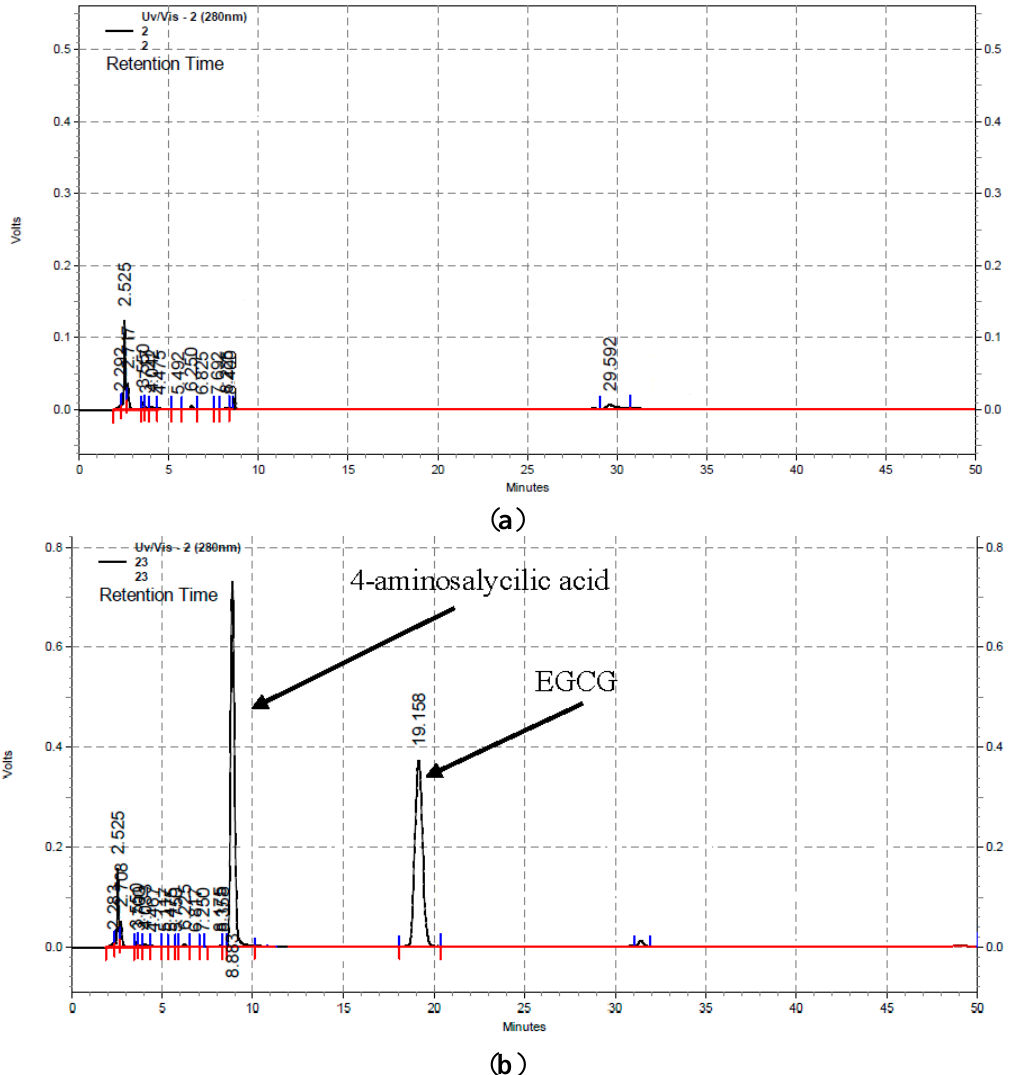
Figure 1. Typical HPLC-UV chromatograms (280 nm) of extracts from strawberry sorbet without ( a ) and with ( b ) the addition of EGCG (2.5 mg/g) and 4-aminosalycilic acid acting as internal standard (100